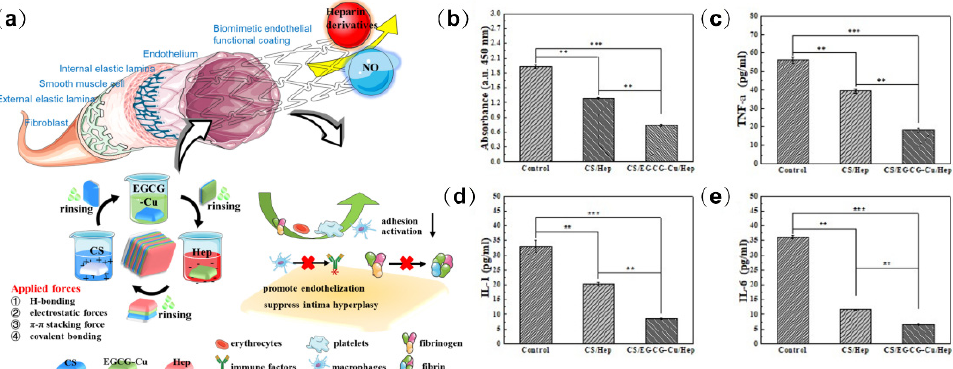
Figure 9. Illustration for the preparation and inflammation assessment of the sandwich-like LBL- coated stents ( a ) The coating that was fabricated with the sandwich-like LBL coating, in which chi- tosan, EGCG/Cu complex, and heparin was alternatingly assembled ( b ) Proliferation of macrophages that were incubated with samples for 24 h. The expression of TNF- α ( c ), IL-6 ( d ), and IL-1 ( e ). Statistical significance was evaluated using a one-way analysis of variance (ANOVA), ** p < 0.01, *** p <